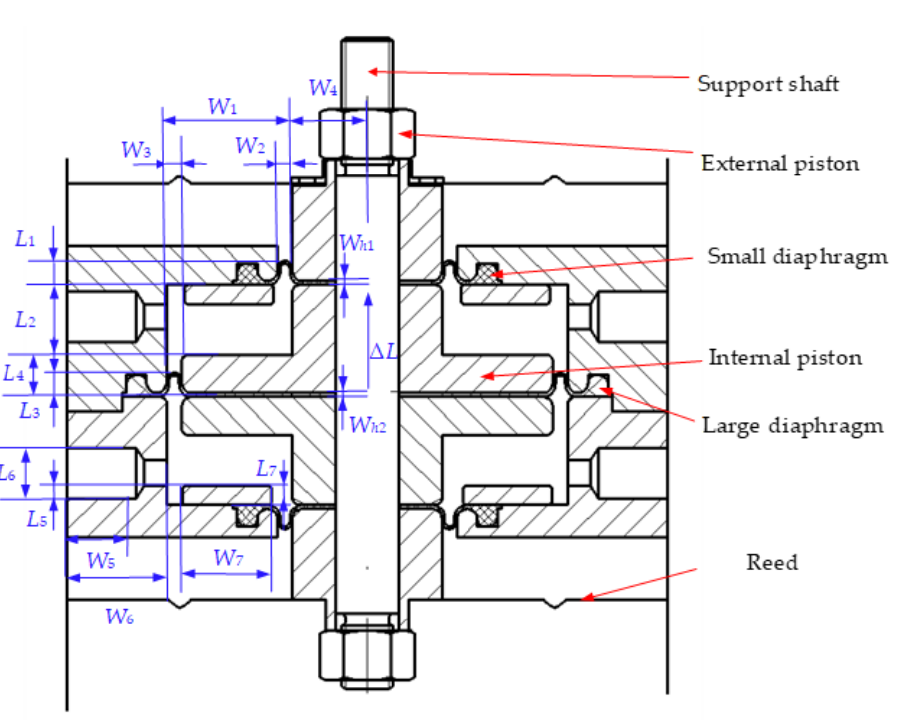
Figure 2. Structure of support cylinder.